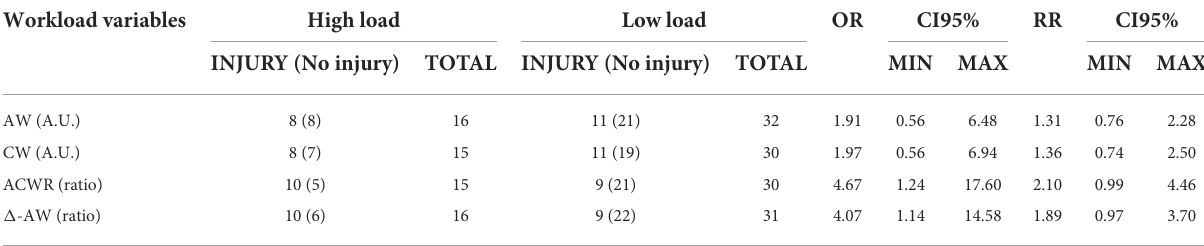
TABLE 3 Injury risk related to different load levels and workload parameters with OR and RR. Workload variables